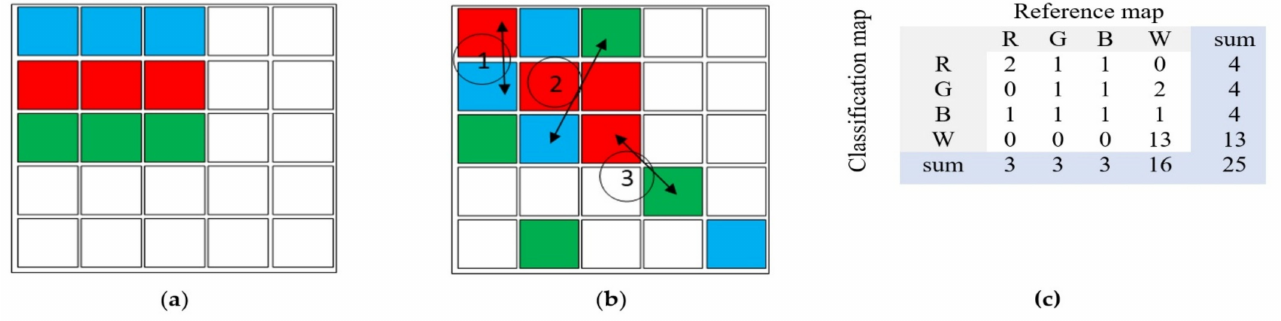
Figure 1. Example to describe the functionality of QADI reference map ( a ), classified map ( b ), and error matrix ( c